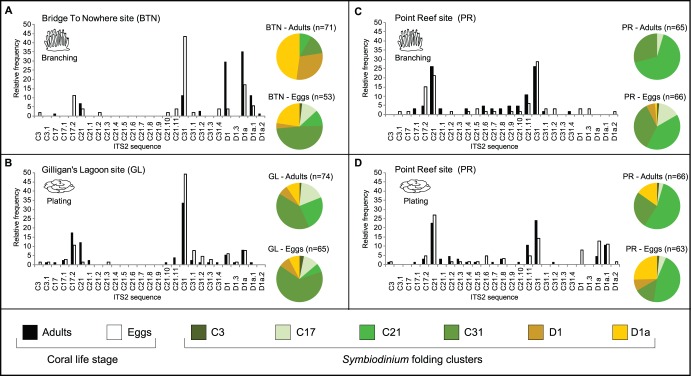
Abundance and distribution of Symbiodinium sequences and clusters between sites.The frequency of Symbiodinium ITS2 sequences per site (adult and egg) is displayed as bar graphs. The pie charts represent the frequency of Symbiodinium based on six of the seven ITS2 secondary structures (folds a, b, c, d, f and g; see Figure S1); note that fold type e did not meet our criteria for inclusion and was omitted from the downstream analysis.